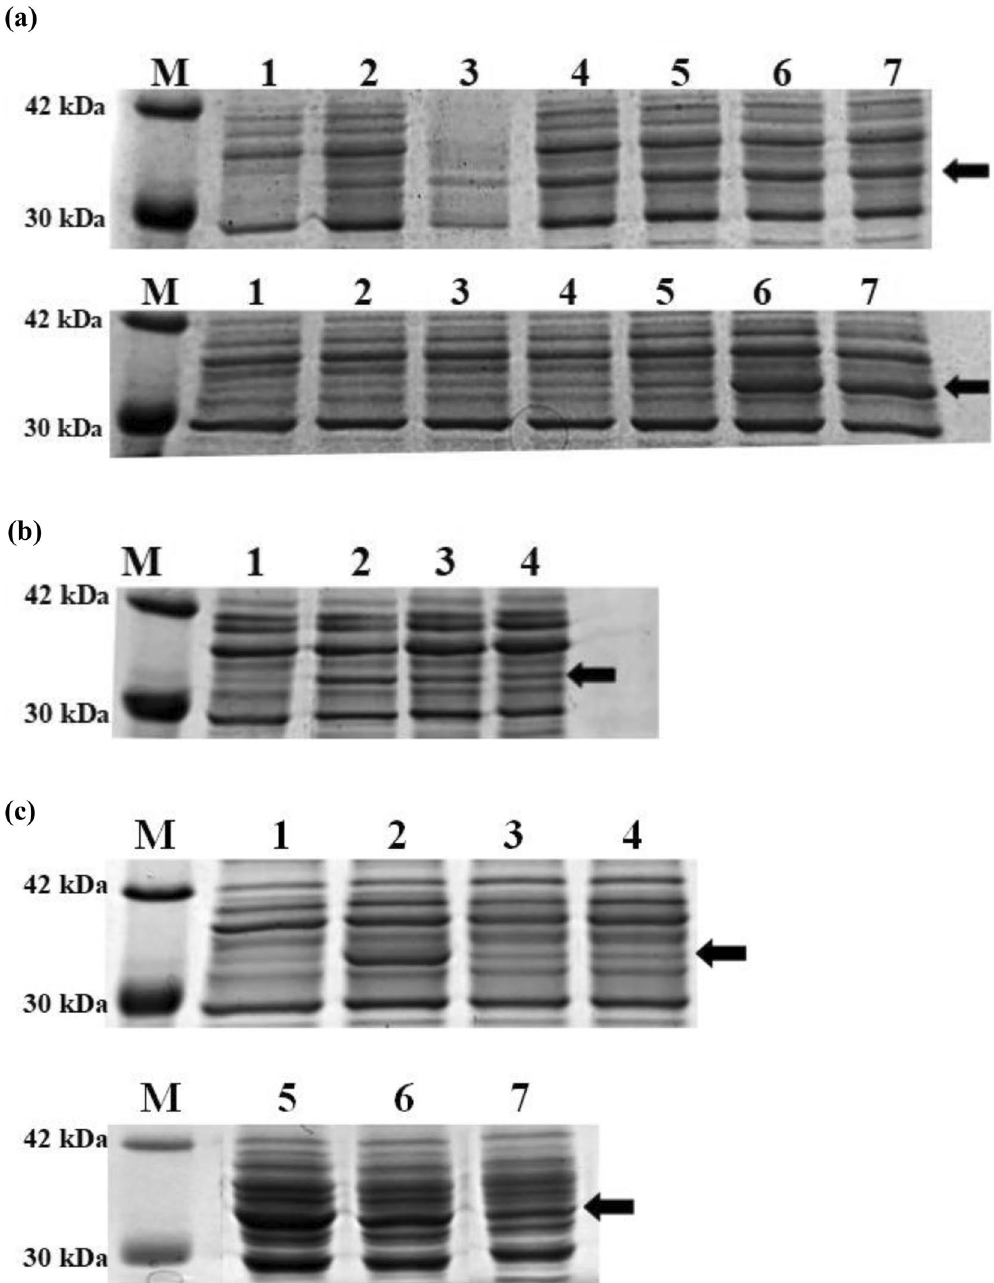
Figure 2. HlyE production and functional activity. ( a )The SDS-PAGE analysis of HlyE. The production of HlyE in either EcNe/HlyE (top) or EcN/HlyE (bottom) was conducted with LB medium. The arrow indicates the location of HlyE in SDS-PAGE. Lane 1, without induction (−); lane 2, induction (+)/10 μM L-arabinose; lane 3, (+)/30 μM L-arabinose; lane 4, (+)/50 μM L-arabinose; lane 5, (+)/100 μM L-arabinose; lane 6, (+)/1 mM L-arabinose; lane 7, (+)/10 mM L-arabinose. ( b ) The effect of glucose on the HlyE production in EcNe/HlyE. EcNe/HlyE was grown on LB medium plus various amounts of glucose and induced for the HlyE production by adding 50 μM L-arabinose. Lane 1, (−)/nil glucose; lane 2, (+)/nil glucose; lane 3, (+)/glucose of 4 g/100 ml; lane 4, (+)/glucose of 10 g/100 ml. ( c ) The effect of glucose on the HlyE production in EcN/HlyE. EcN/HlyE was grown on LB medium plus various amounts of glucose and induced for the HlyE production by adding 1 mM L-arabinose. Lane 1, (−)/nil glucose; lane 2, (+)/nil glucose; lane 3, (+)/glucose of 4 g/100 ml; lane 4, (+)/glucose of 10 g/100 ml; lane 5, (+)/nil glucose; lane 6, (+)/glucose of 0.1 g/100 ml; lane 7, (+)/glucose of 0.2 g/100